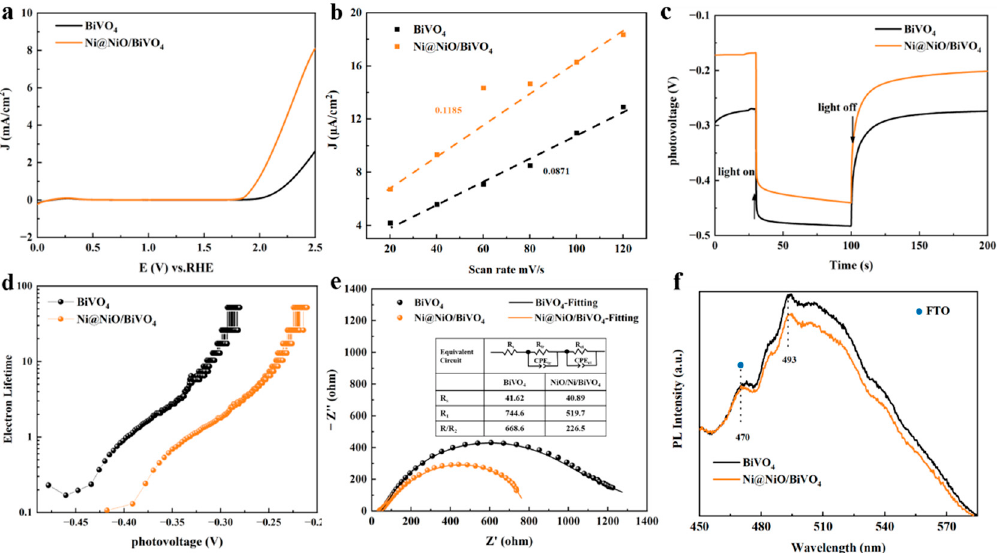
Figure 4. ( a ) LSV curves in the dark. ( b ) Plot of the capacity current as a function of the scan rate. ( c ) Open-circuit voltages of BiVO 4 , Ni/BiVO 4 and Ni@NiO/BiVO 4 photoanodes in the dark and under illumination. ( d ) The corresponding lifetimes indicate the OCP decay times of BiVO 4 , Ni/BiVO 4 and Ni@NiO/BiVO 4 photoanodes after turning off the light. ( e ) EIS Nyquist plot at an open circuit voltage under illumination. ( f ) Photoluminescence spectroscopy of BiVO 4 , Ni/BiVO 4 and Ni@NiO/BiVO 4 photoanodes.